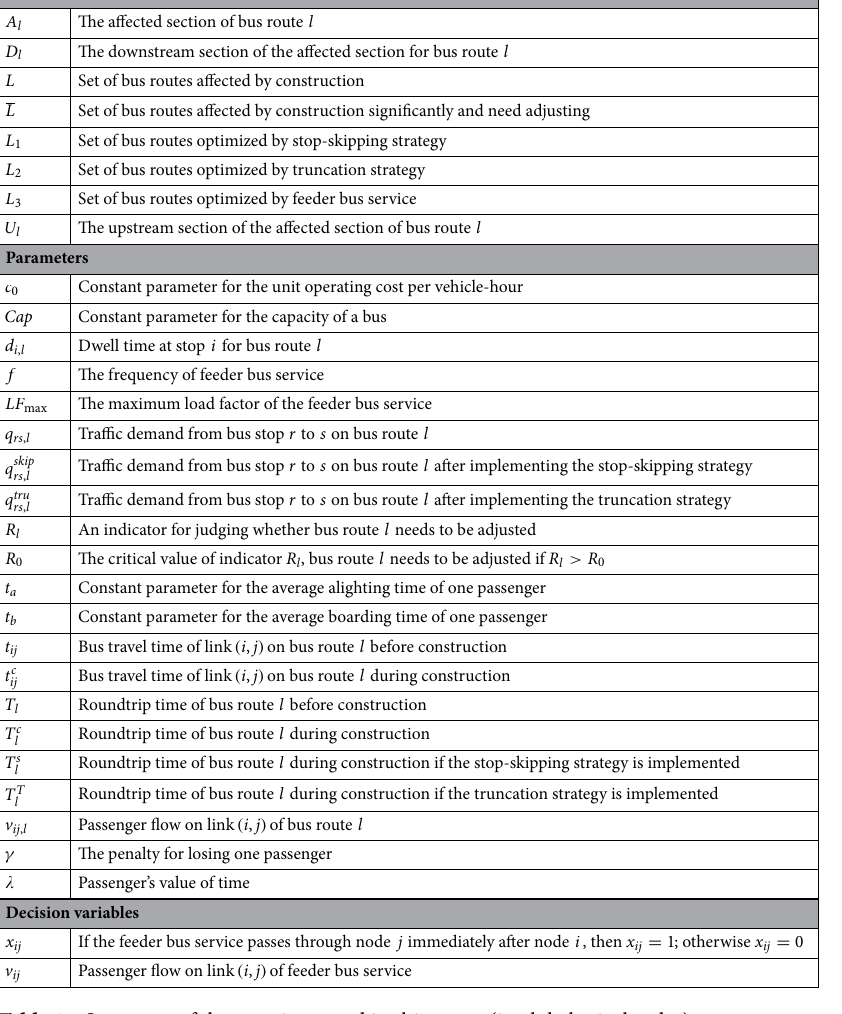
Table 1. Summary of the notations used in this paper (in alphabetical